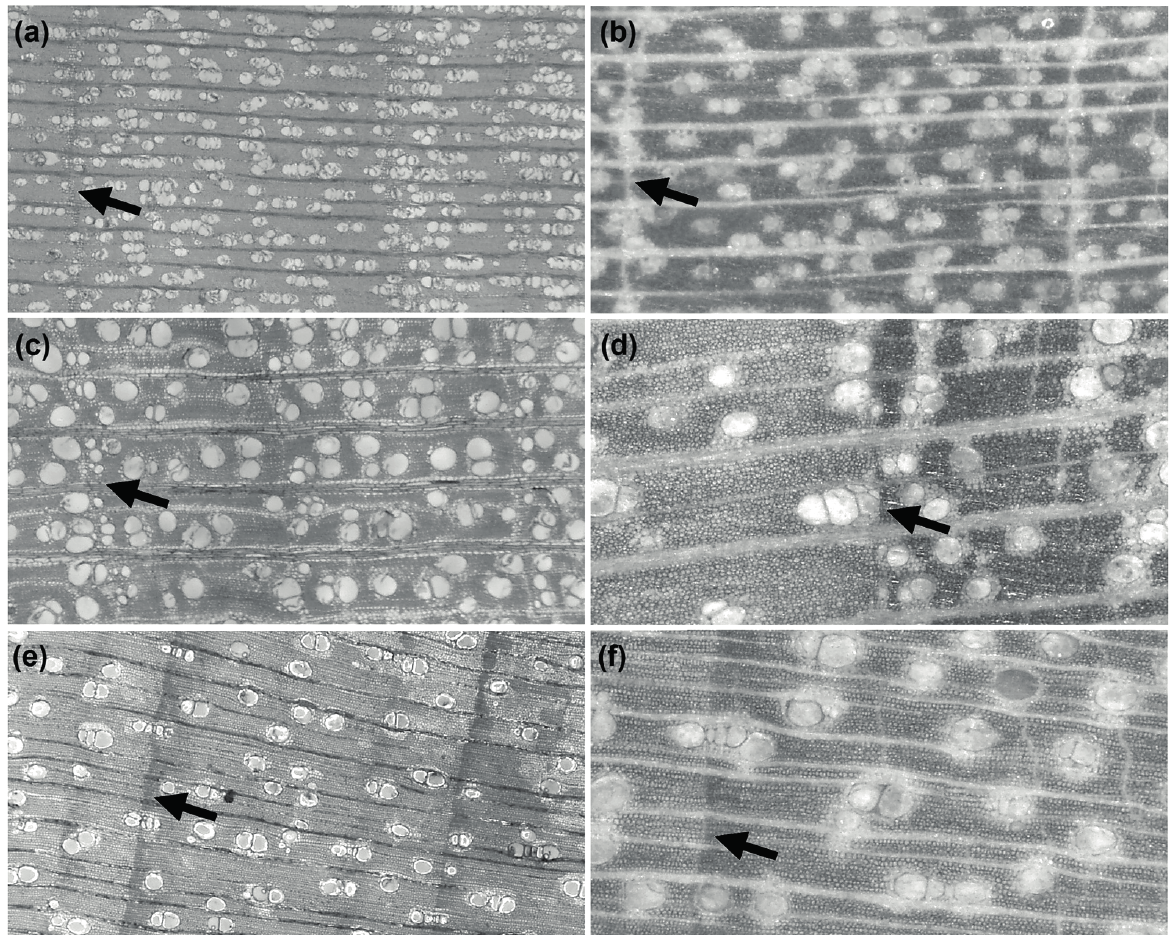
Figure 2 - Wood anatomy of the species. Tree rings characterized in Balfourodendron riedelianum by the combination of latewood thick-walled fibers and marginal parenchyma (a) and (b) ; Cordia trichotoma by latewood made up of small and medium-sized vessels, thick-walled fibers and axial parenchyma (c) and (d) ; Ocotea diospyrifolia by a darker tangential line and radial thick- walled fibers (e) and (f) . Arrows indicate the ring